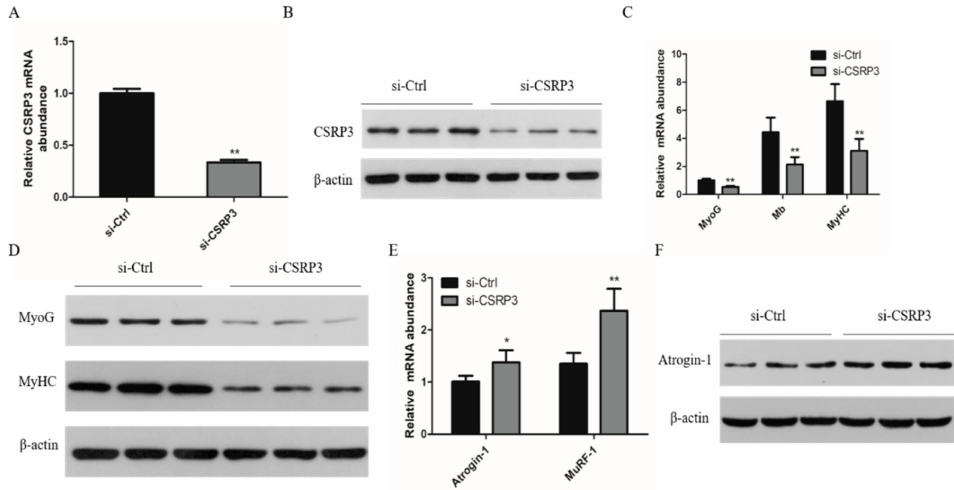
Figure 2. CSRP3 regulates the development of skeletal muscle myoblasts in chicken. ( A and B ) CSRP3 mRNA and protein in myoblasts transfected with si-CSRP3 of si-Ctrl. ( C and D ) The mRNA expression of MyoG, Mb, and MyHC, and protein abundance in myoblasts transfected with si-CSRP3 of si-Ctrl. ( E and F ) The mRAN and protein level of Atrogin-1 and MuRF-1 mRNA in myoblasts transfected with si-CSRP3 of si-Ctrl. Data are expressed as mean ± SEM of three independent experiments. * p < 0.05, ** p <